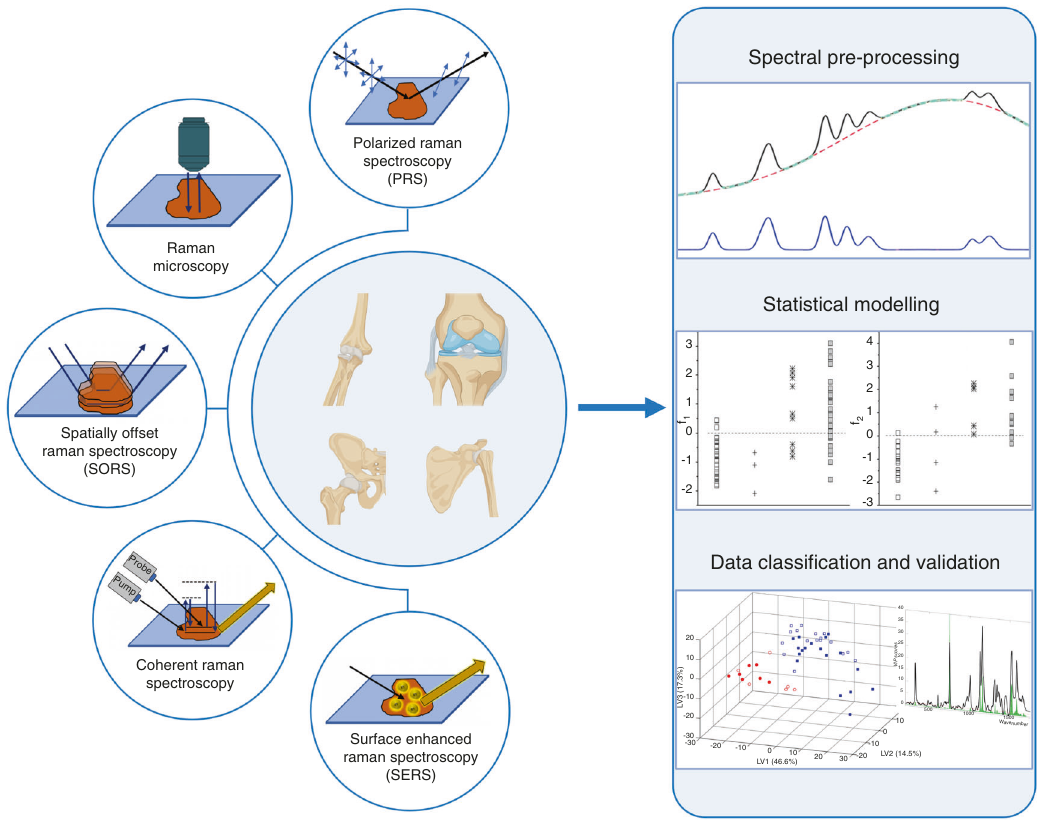
Fig. 5 Summary of Raman spectroscopy techniques: polarized Raman spectroscopy (PRS), suitable for highly oriented systems; Raman microscopy, able to couple chemical and morphological information; spatially offset Raman spectroscopy (SORS), used for collecting Raman signal from deep regions; coherent Raman spectroscopy (SRS & CARS), able to improve Raman signal intensity up to 10 5 factor; and surface enhanced Raman spectroscopy, (SERS) able to enhance signal intensity up to 10 10 factor, exploiting the plasmonic effect between the sample and metal particles. The processing of Raman data collected from biological samples is accomplished by spectral analysis and statistical